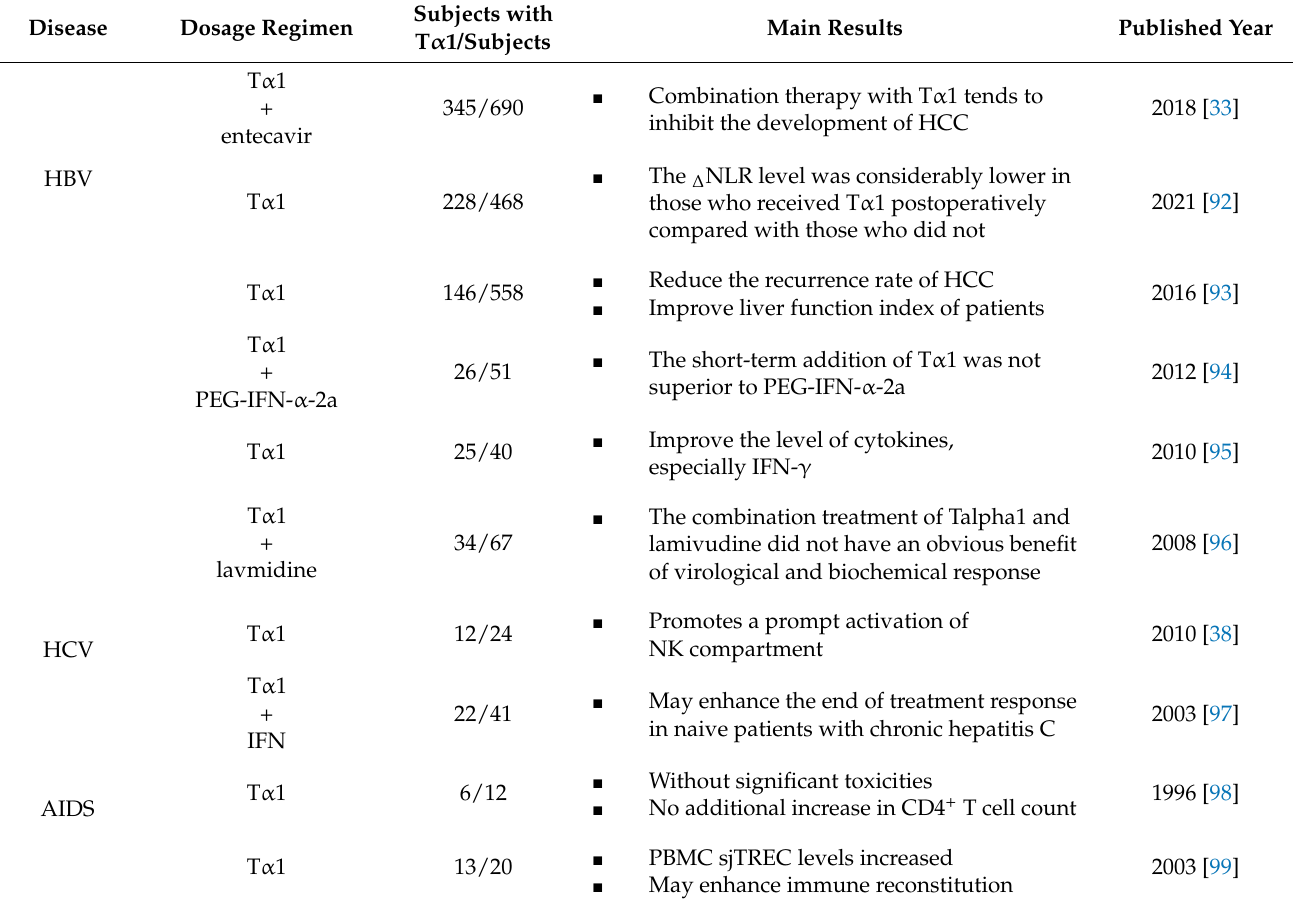
Table 2. Clinical research of T α 1 on other diseases. Disease Main